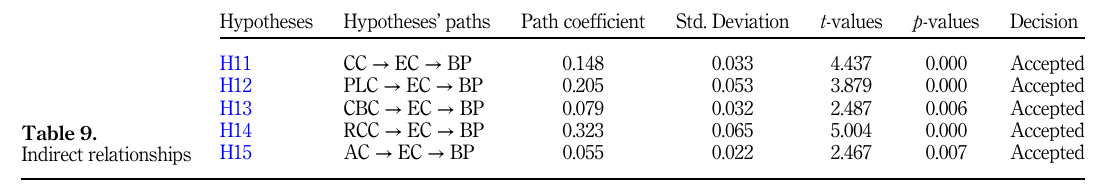
Table 9. Indirect relationships